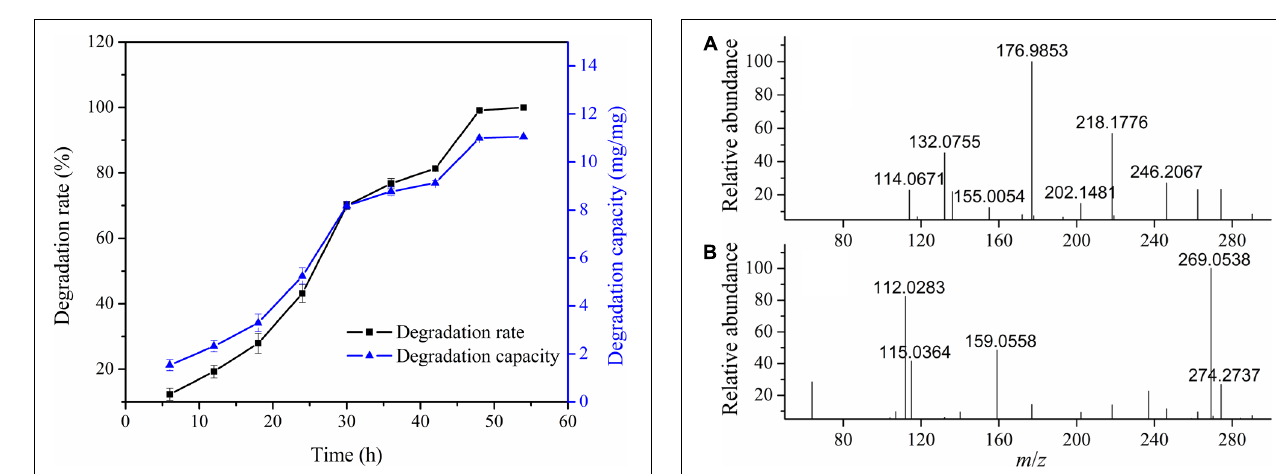
FIGURE 8 | MS/MS before (A) and after (B) PPL degradation.